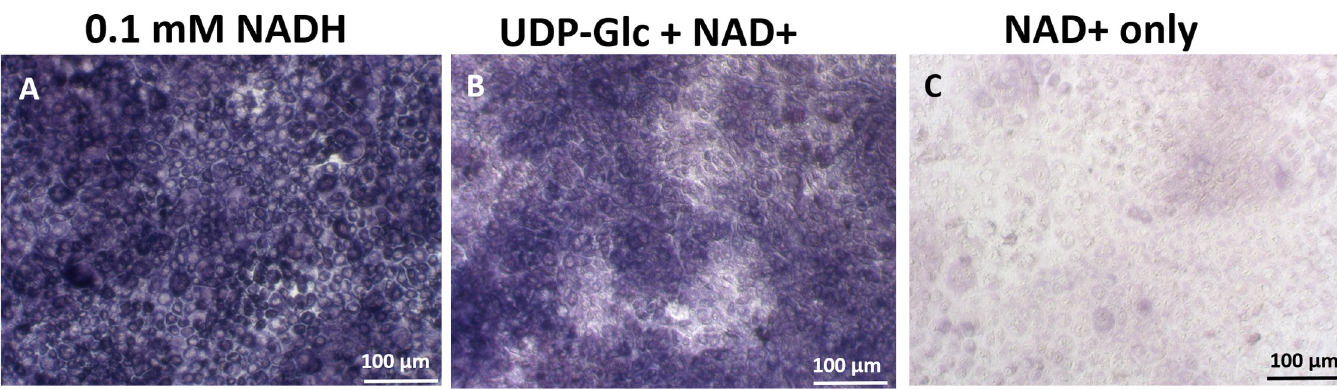
Fig 4. Intense UGDH and diaphorase enzyme histostaining activity in transformed A549 cells. By in situ enzyme staining, A549 cells showed relatively high (A) 99.8% diaphorase/GR staining with 0.1 mM NADH, (B) 93.1% UGDH enzyme staining and (C) 12.1% background NBT staining in the absence of UDP-Glc compared to primary human FLS. Scale bars: 100 μ